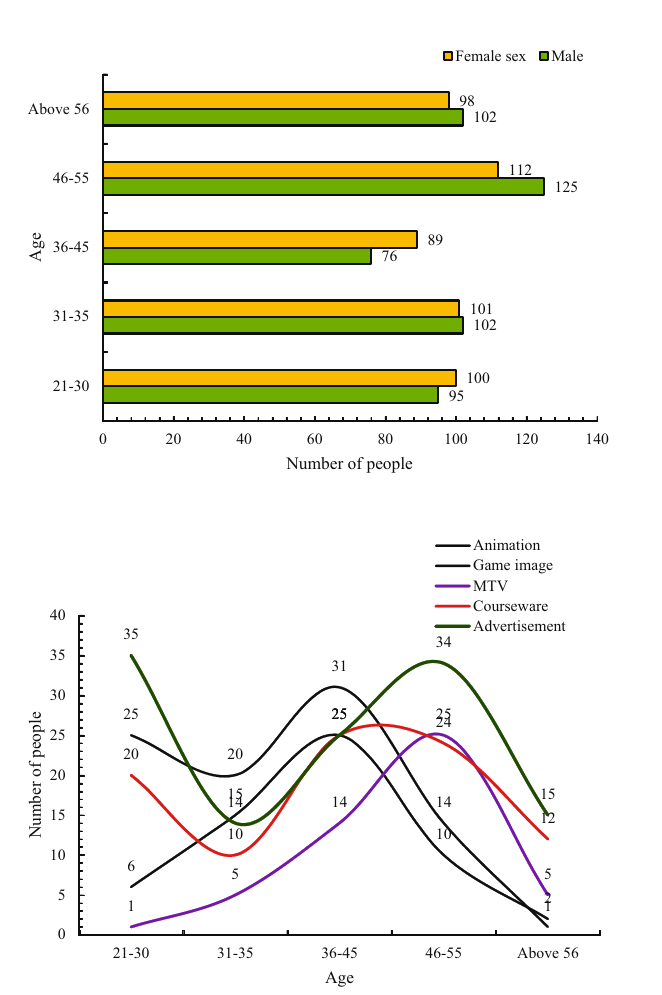
Figure 10: Identity of the